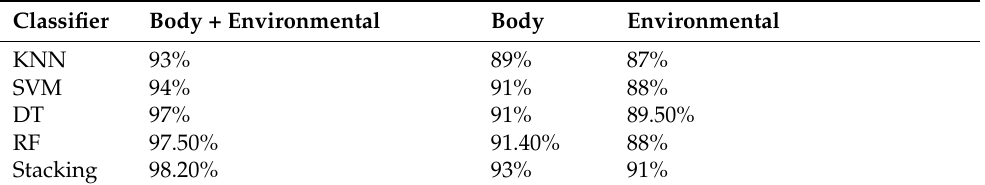
Table 10. A Comparison between results of classifiers for (each modality and entire data) and the stacking learner of